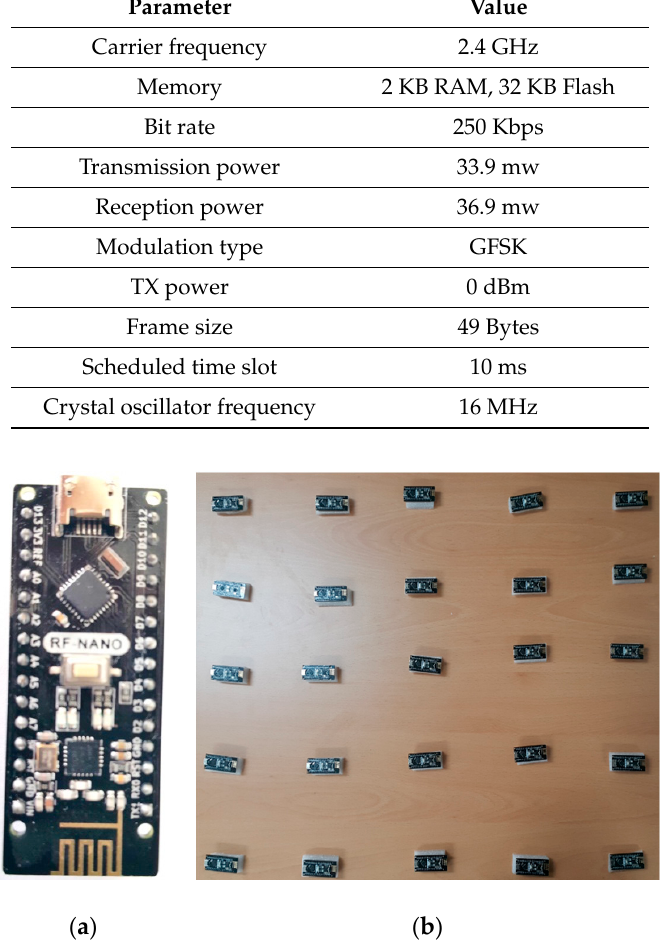
Figure 2. ( a ) Hardware platform ( b ) Set up of a network of 25 sensor nodes for the experiment.